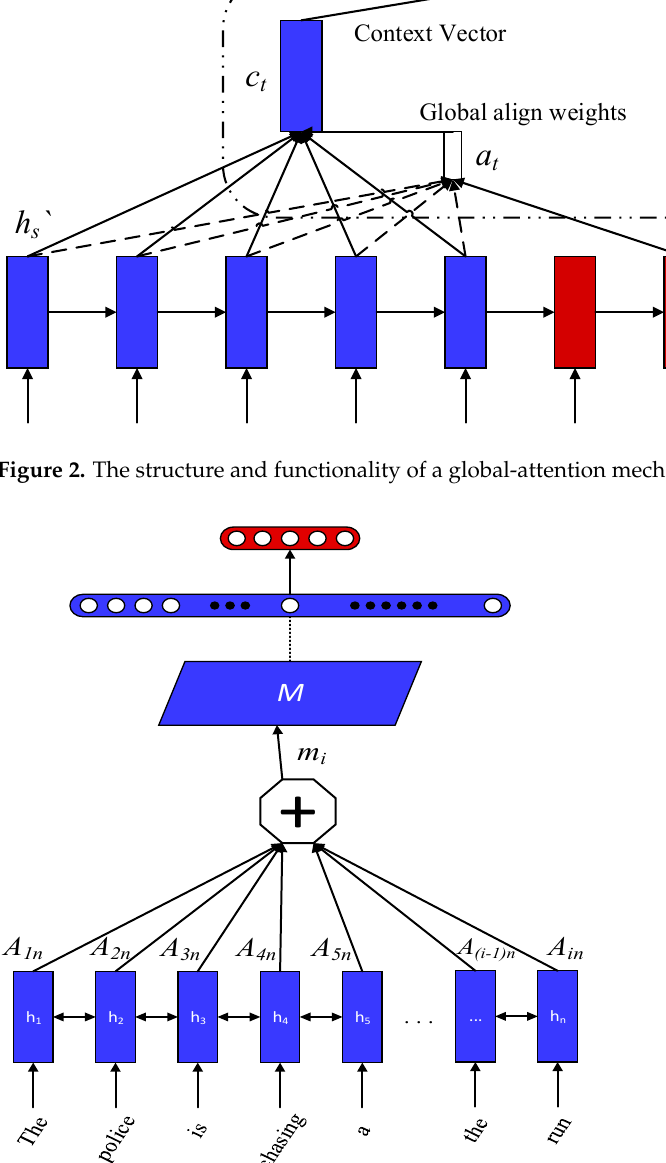
Figure 4. The structure and functionality of a hierarchical-attention network (HAN).